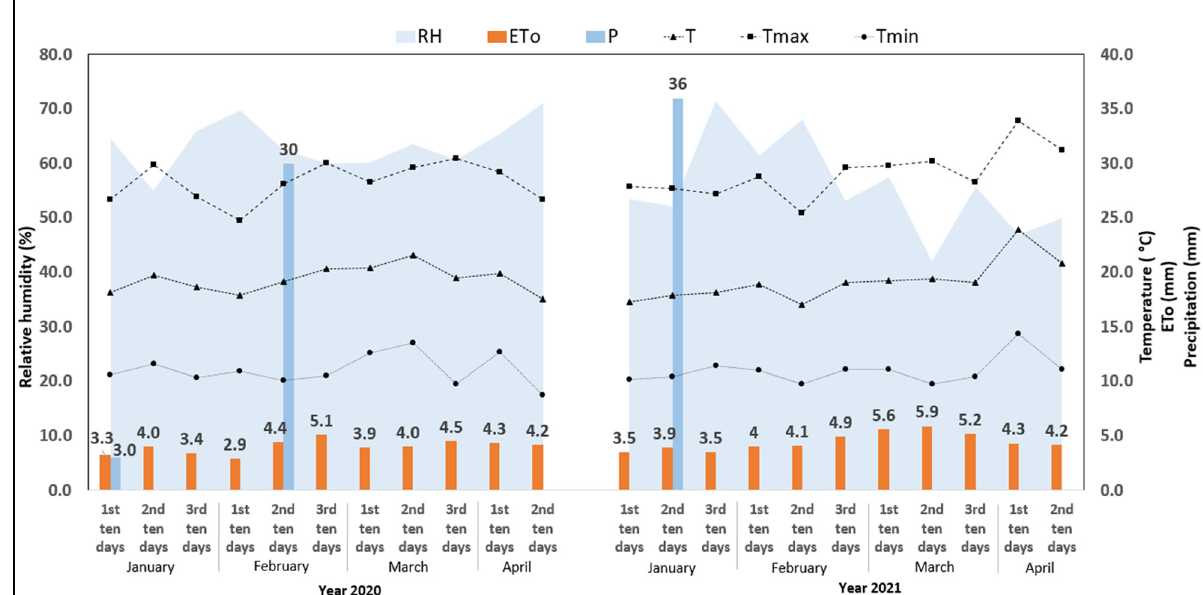
Figure 3. Relative humidity (RH; %), ten-day reference evapotranspiration (ETo; mm), precipitation (P; mm), average temperature (T; °C), and maximum (Tmax; °C) and minimum (Tmin; °C) temperatures during two consecutive years of evaluation.